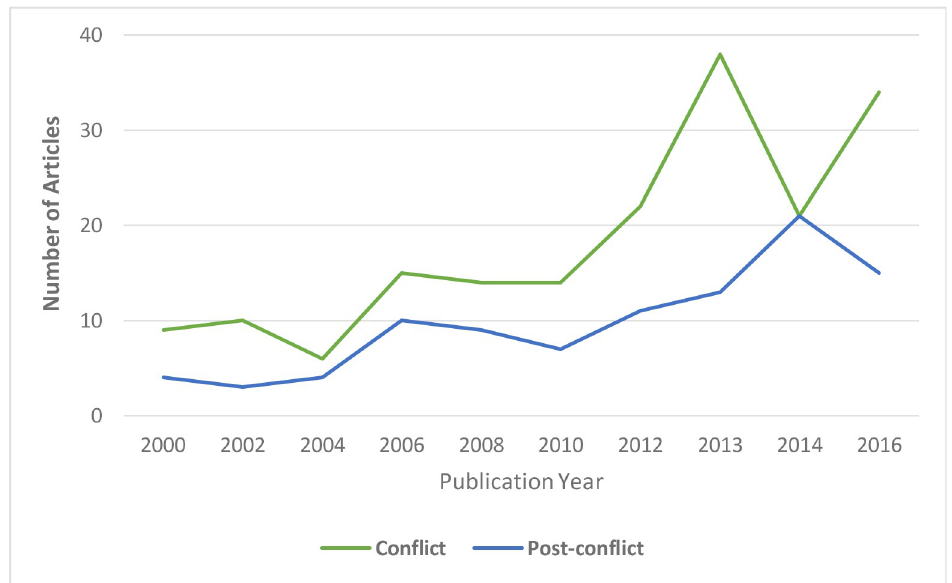
Fig 3. Publication year of articles of the papers included in the systematic maps in conflict (N = 325) and post- conflict settings � . https://doi.org/10.1371/journal.pone.0233757.g003 downloaded using the following links for conflict settings (http://evidencemaphcw.com/ gapmap/conflict) and for post-conflict settings (http://evidencemaphcw.com/gapmap/post- conflict). The maps allow data to be filtered and sorted by type of primary studies